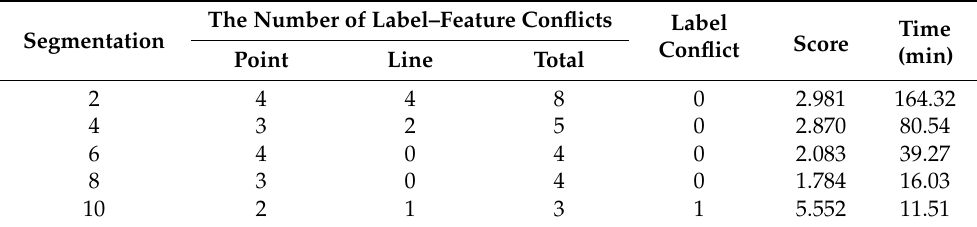
Table 3. Applying different numbers of segmentations on the second